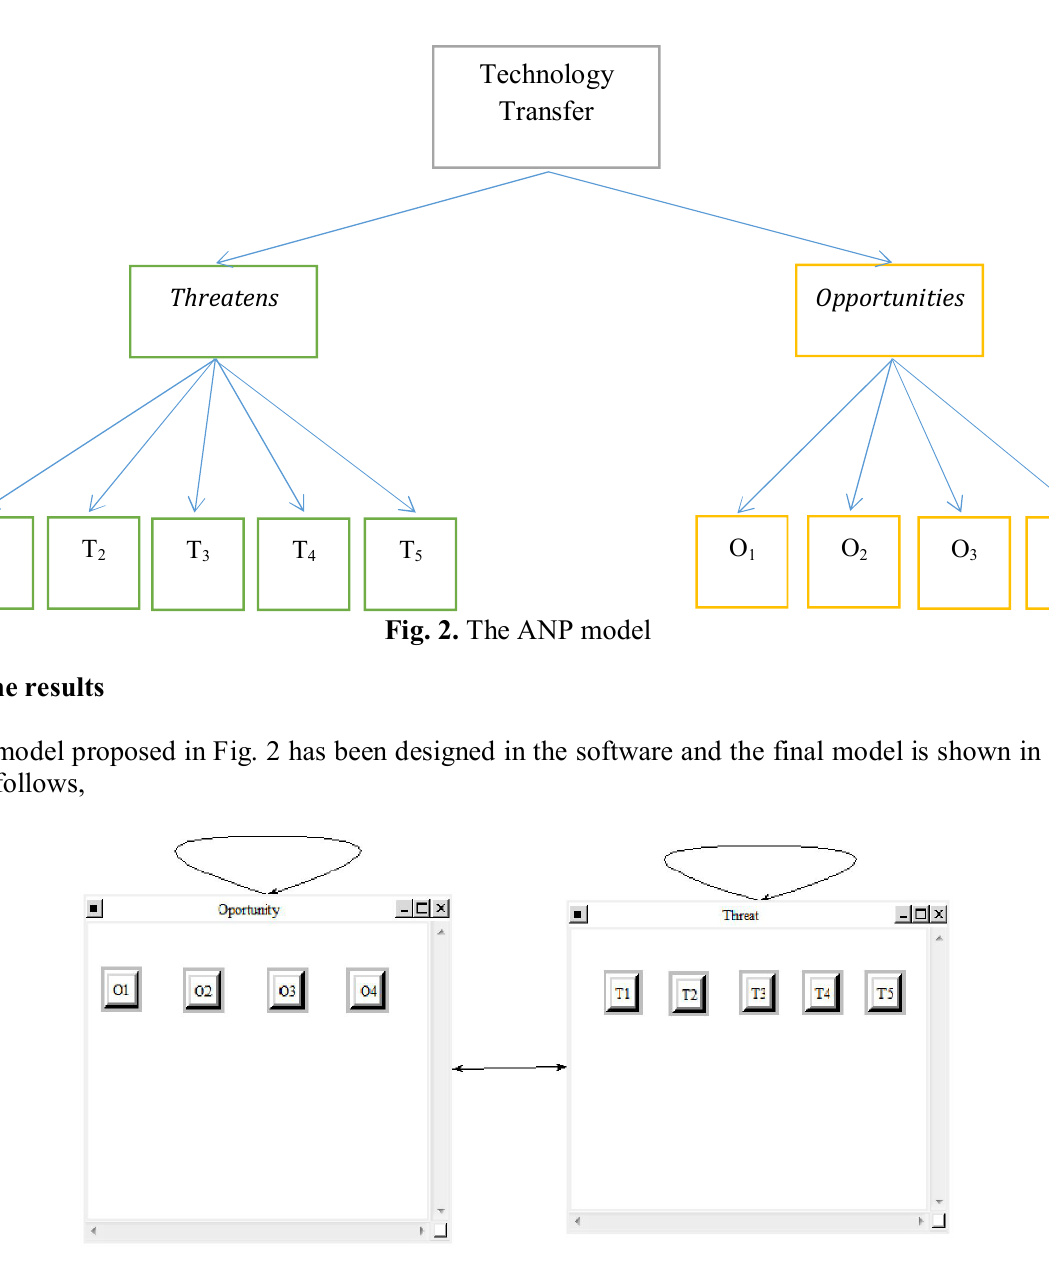
Fig. 3. Drawn model in the Super Decision